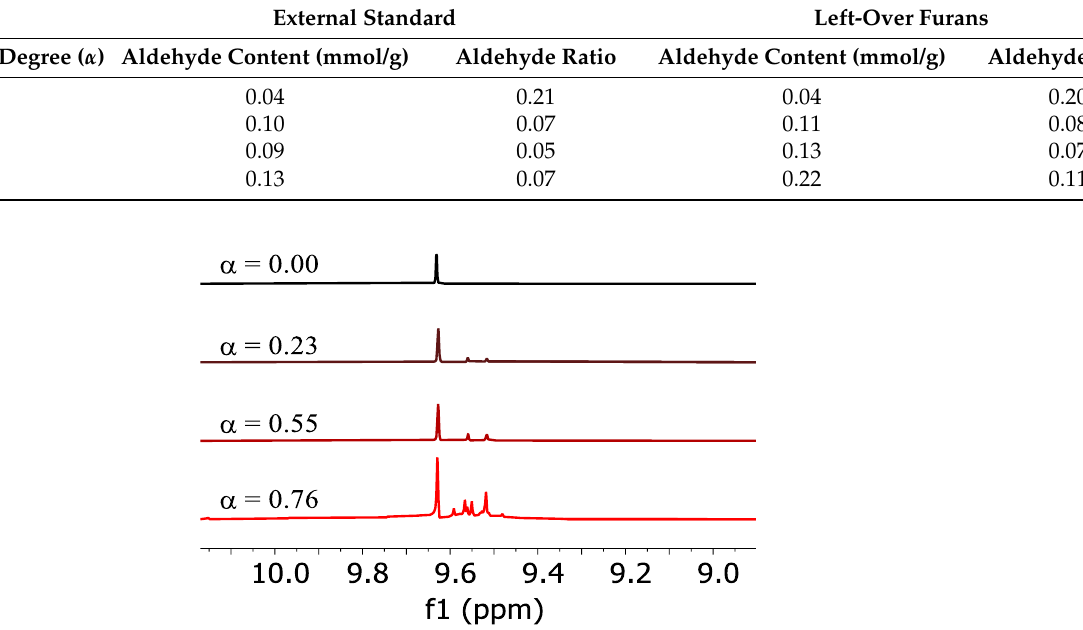
Table 1. Results of the aldehydes’ quantification in the PFA° resin.